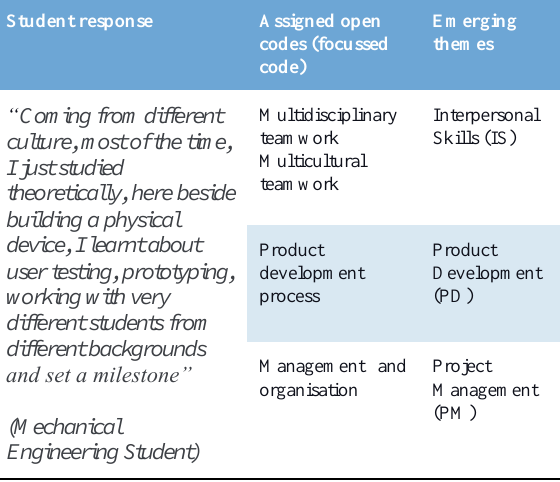
Table 2. Student Response coding